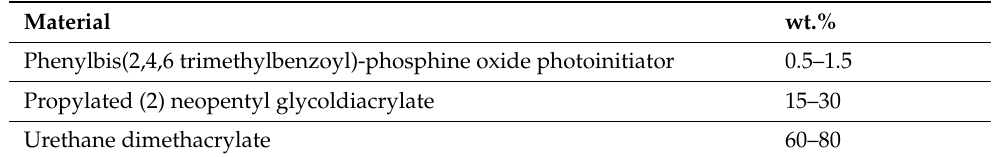
Table 1. Materials used to synthesize E-Shell 200